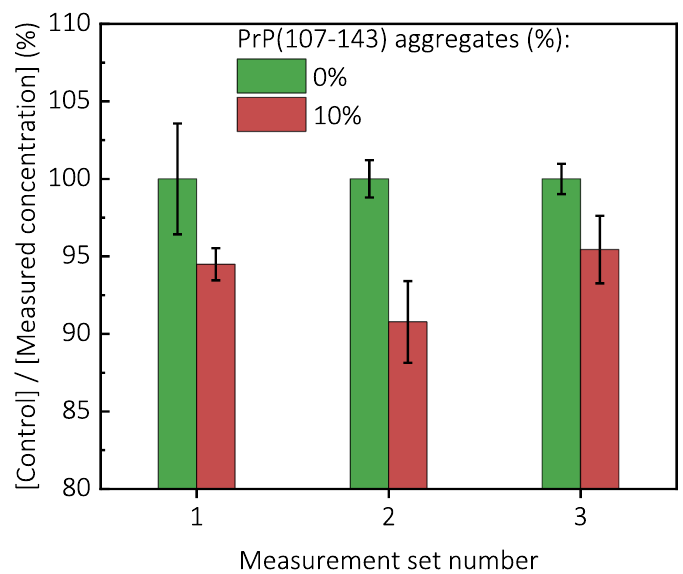
Figure A8. Measurements of PrP(89-230) concentration bound to the fibrils formed by PrP(107-143). For the measurements of monomeric PrP(89-230) binding to PrP(107-143) fibrils, 1 mL solutions of 0.5 mg/mL of monomeric PrP(89-230) in 0.5 M GuHCl, 50 mM phosphate buffer (pH 6) supplemented with none or 0.05 mg/mL of PrP(107-143) fibrils were centrifuged at 12,000 × g for 30 min. Subsequently, concentration of monomeric PrP(89-230) remaining in the supernatant was determined by measuring UV-absorption at 280 nm using NanoDrop 2000 (Thermo Fisher Scientific). Error bars are standard deviations estimated from three repeats.